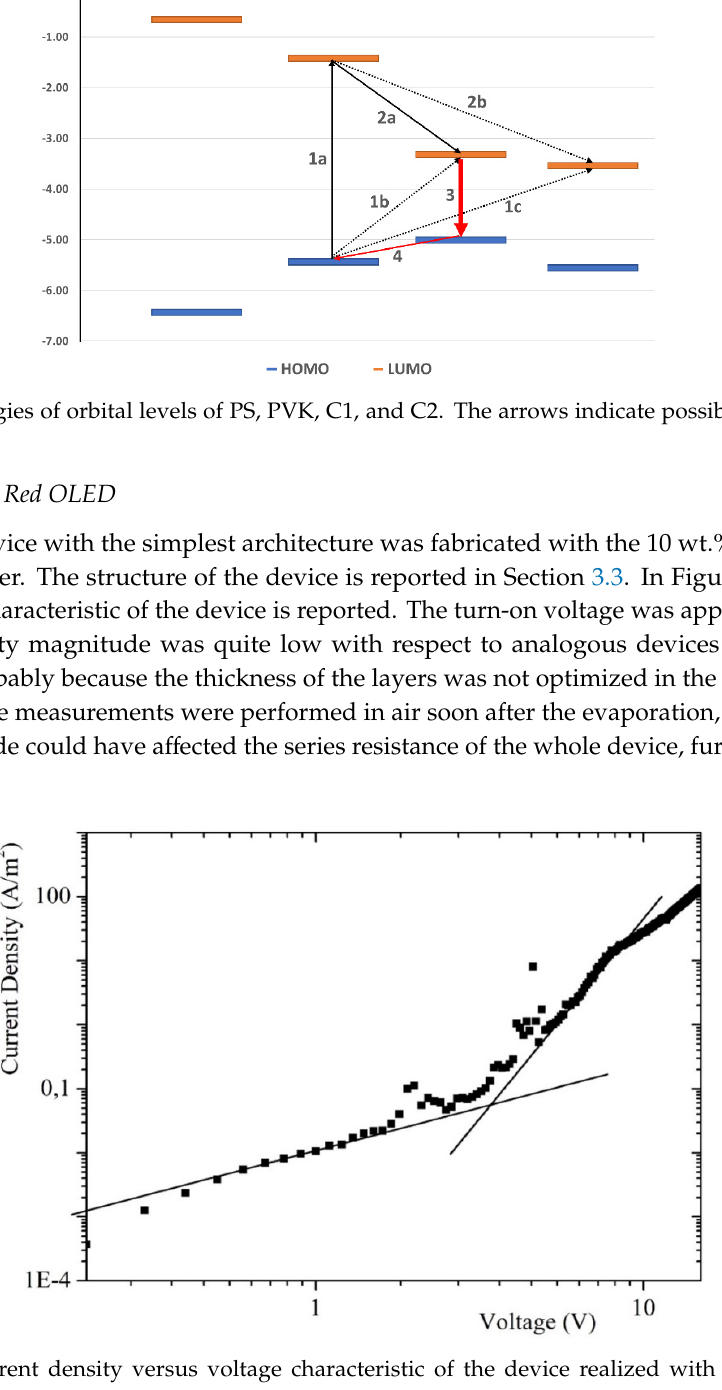
Figure 2. Frontier orbital representation for systems C1 ( a ) and C2 ( b ).